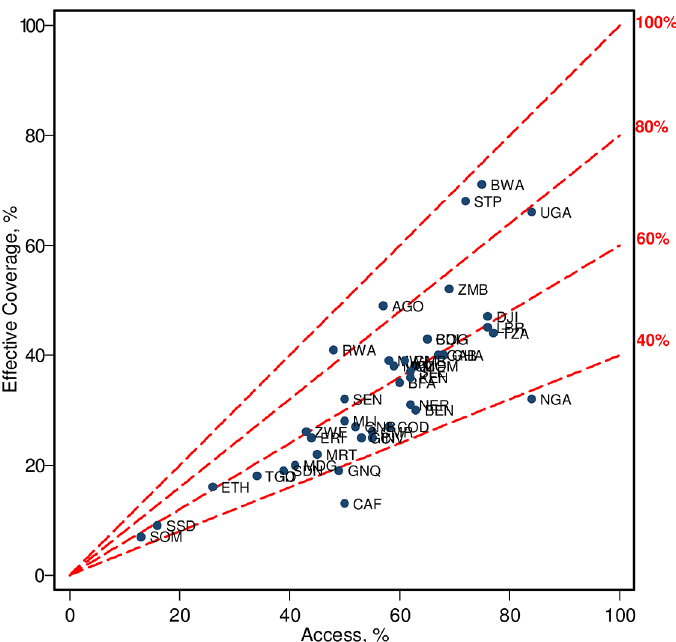
Fig 3. Effective Coverage ( E ) and Access to Any Provider ( A ) by Country (%). Dashed lines starting with a 45 degree angle and steeper illustrate the ratio of fever episodes treated effectively (Effective Coverage) over episodes for which treatment was sought (Access). Labels for country ISO3 codes are listed in the S1